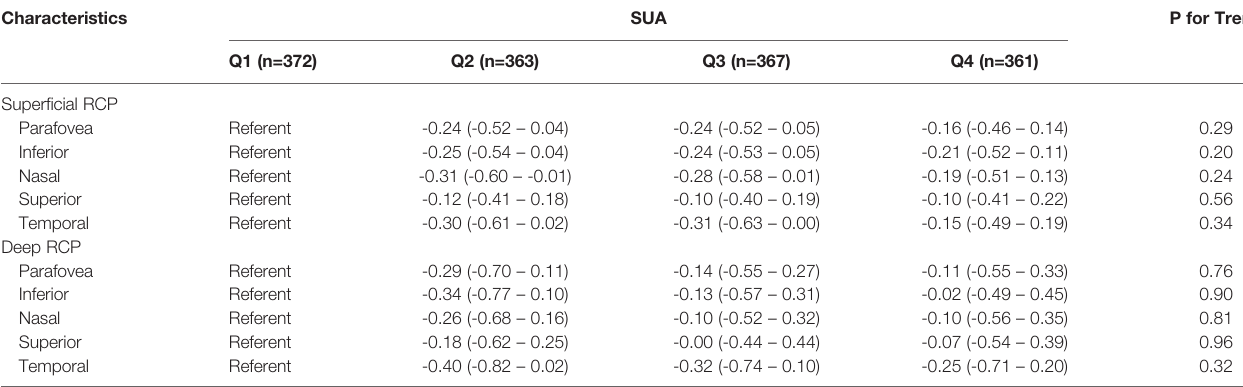
TABLE 4 | Association between serum uric acid and retinal capillary plexus in women.